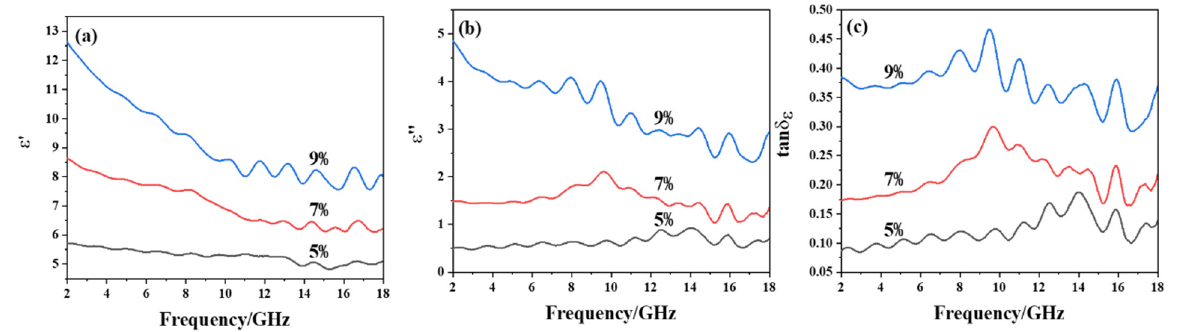
Figure 5. Complex permittivity of HPCNF composites: ( a ) real part; and ( b ) imaginary part of complex permittivity; ( c ) loss factor.